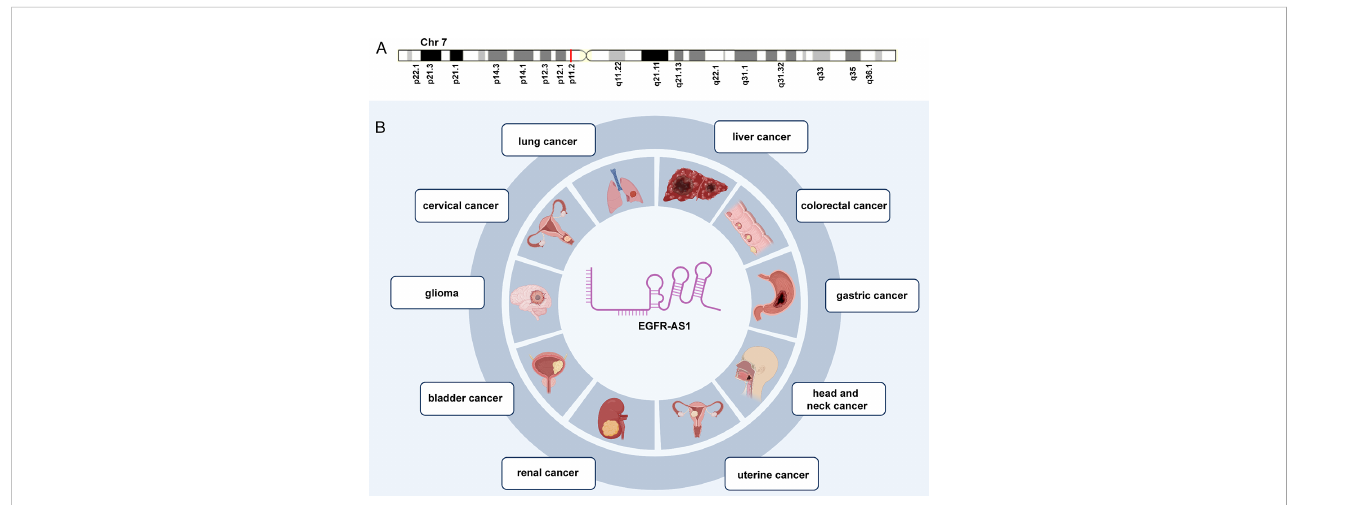
FIGURE 1 The expression and potential roles in cancer types. (A) Chromosomal location of EGFR-AS1. (B) EGFR-AS1 was overexpressed in lung cancer, cervical cancer, glioma, bladder cancer, kidney cancer, head and neck cancer, gastric cancer, colorectal cancer, liver cancer, and uterine